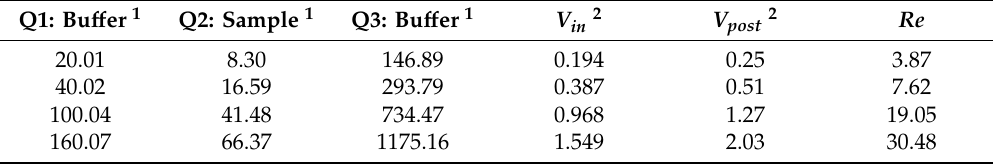
Table 2. Input flow rates and velocities in the inlet channels and between the post and Reynolds